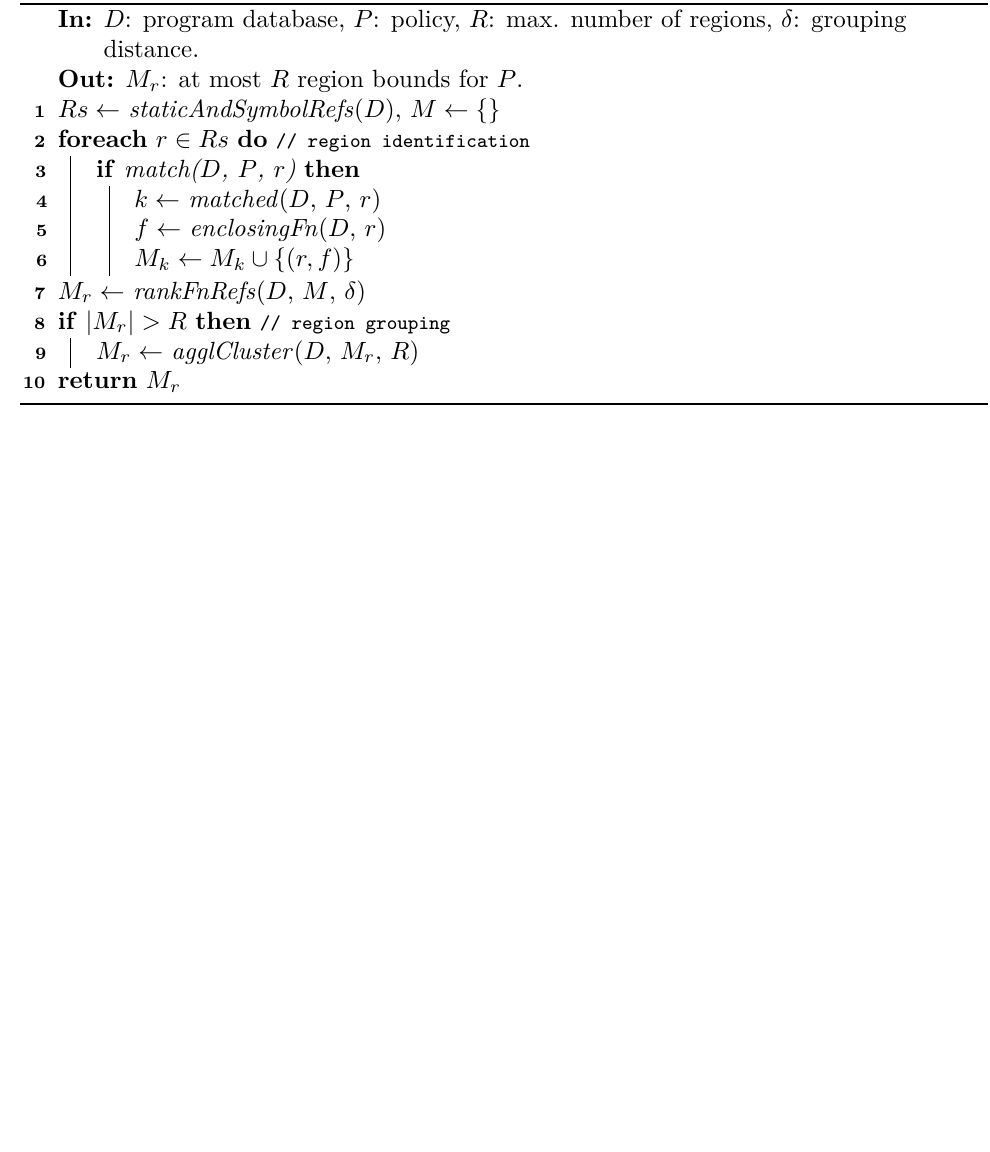
Algorithm 1: Region